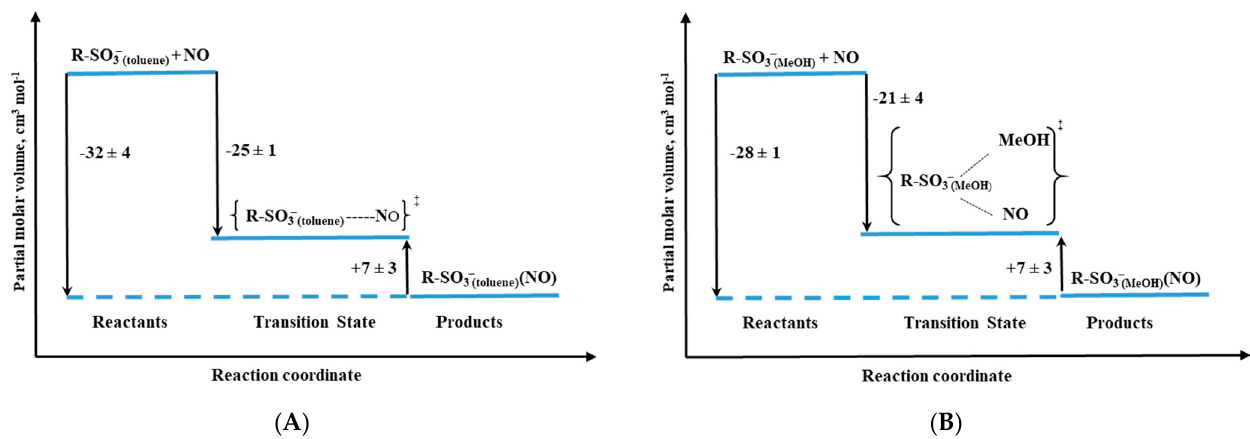
Figure 14. Volume profiles for reversible NO binding to R-SO 3 − model in ( A ) toluene (R-SO 3 − (toluene) ) and ( B ) in methanol (RSO 3 − (MeOH) ).